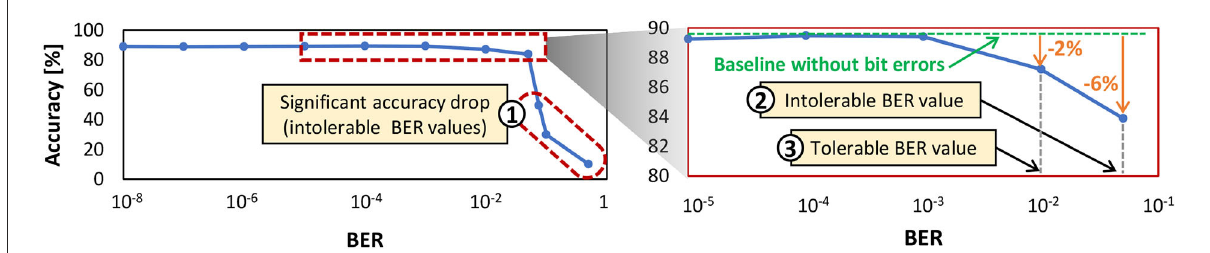
FIGURE8 The test accuracy profile of a 900-neuron network across different BER values shows the tolerable and intolerable BER. This network has a fully-connected architecture like in Figure 3A where each input pixel is connected to all neurons, and the output of each neuron is connected to other neurons for performing inhibition, thereby providing competition among neurons to correctly recognize the input